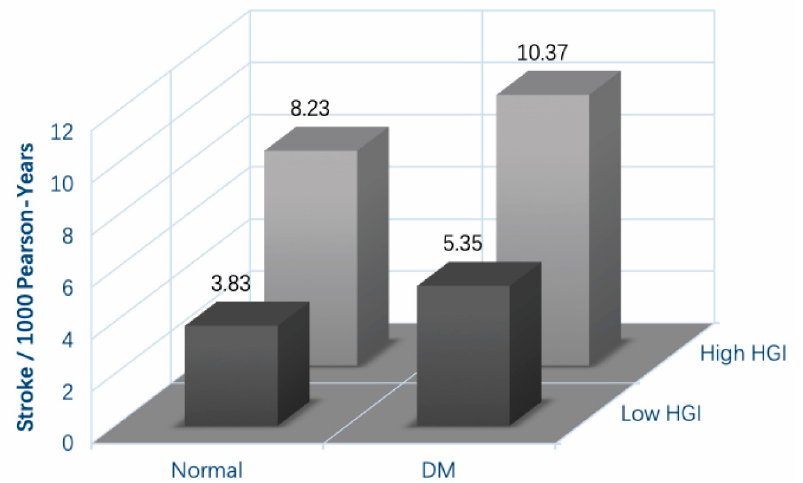
Figure 2. The incidence of onset stroke based on HGI–DM system. After 4.23 years of follow-up, based on HGI–DM system, the highest incidence of stroke took place in both DM and high-HGI subgroups. Moreover, the isolated high-HGI subjects had a slightly higher incidence than the iso- lated DM subjects. Abbreviations: HGI, glycated hemoglobin index; DM, diabetes mellitus.